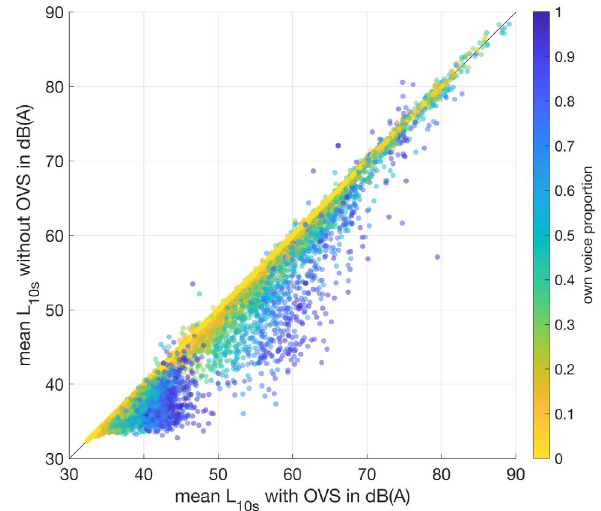
Figure 7. Distribution of the mean A-weighted SPL L 10s calculated for 10 s-intervals with 50% overlap for all participants and recording days, on the horizontal axis including OVS and on the vertical axis excluding OVS. The color indicates the proportion of OVS in each interval.